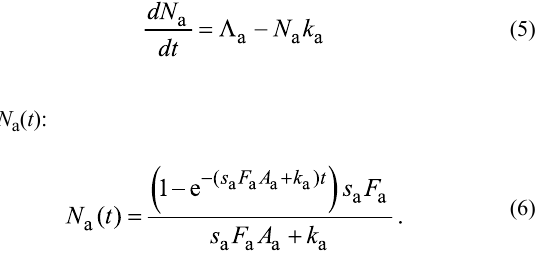
Figure 2. The flux Λ a of precursor molecules physisorbing to vacant surface sites is given by: